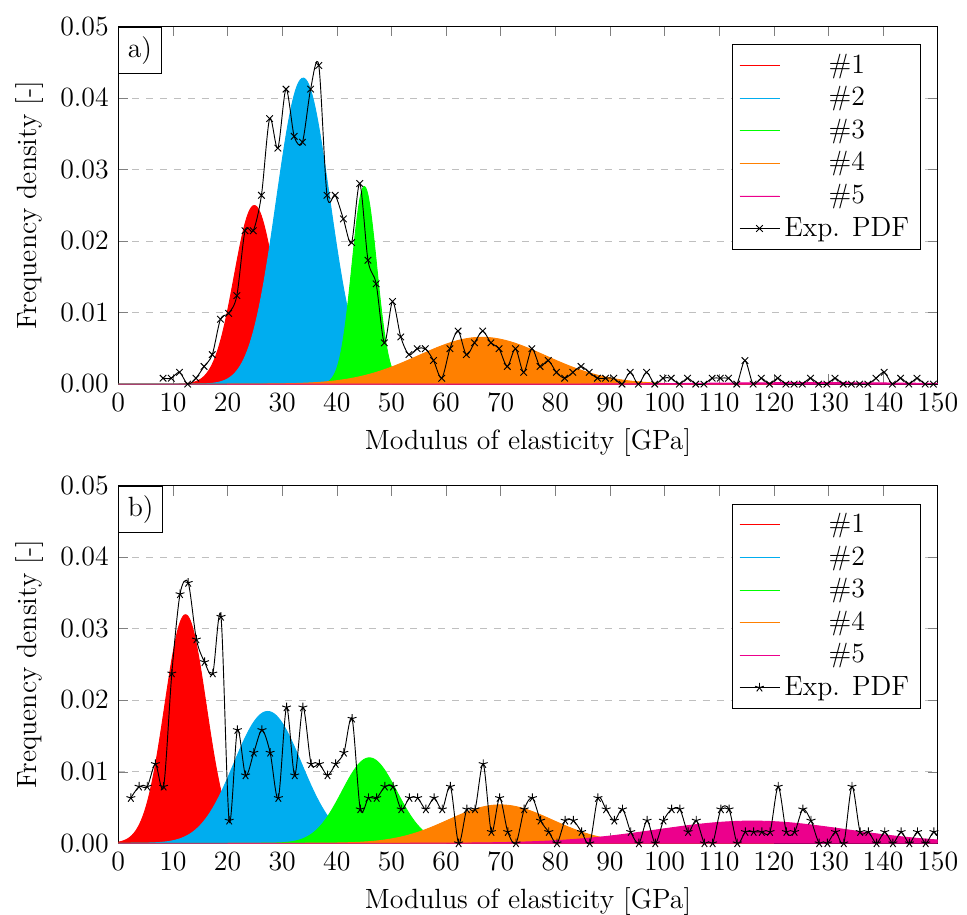
Figure 3. Frequency plots of the samples a) PC b) SL. The bin-size for deconvolution of modulus of elasticity E = 1.5